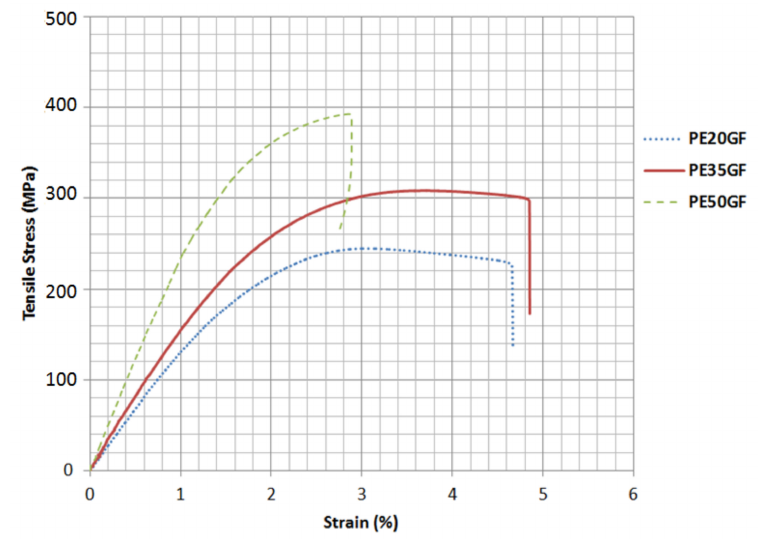
Figure 3. Stress–strain curve for polyester specimens reinforced with 20%, 35%, and 50% fibre volume fractions.